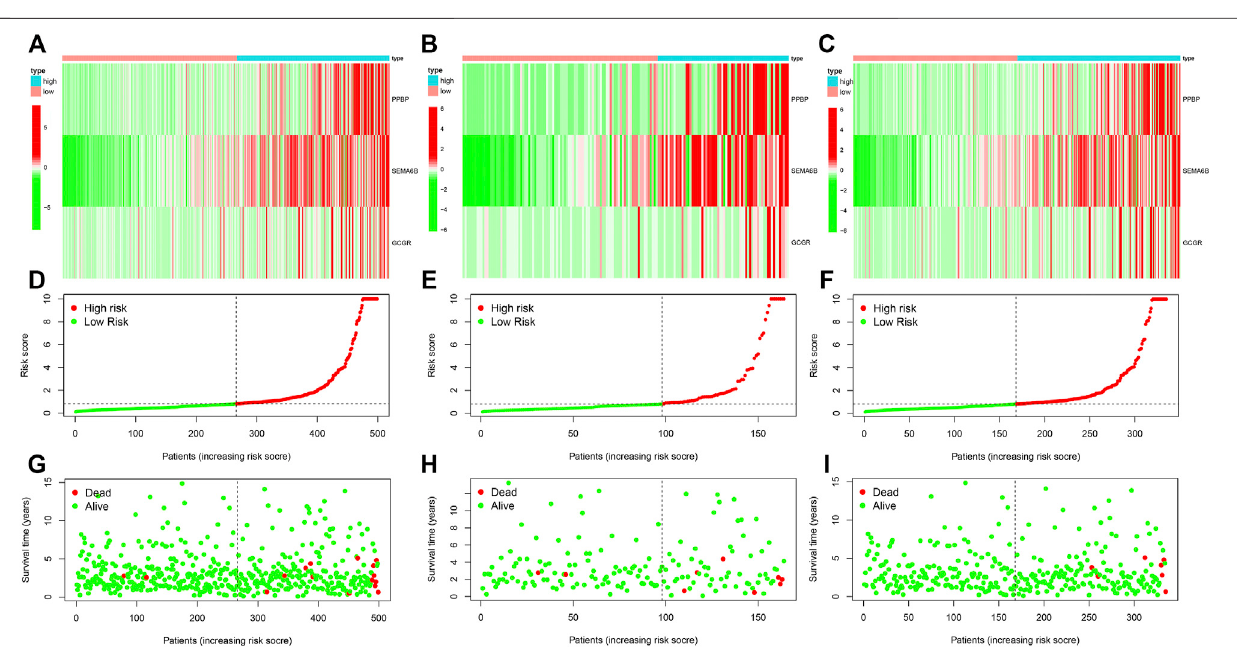
FIGURE 5 | Construction of THCA prognostic model (A – C) Expression levels of three prognostic hub IRDEGs among THCA patients in the combined test, and training cohorts, respectively. (D – F) The distribution of RS among THCA patients in three cohorts. (G – I) The survival status correlated with RS among THCA patients. THCA, thyroid carcinoma; RS, risk